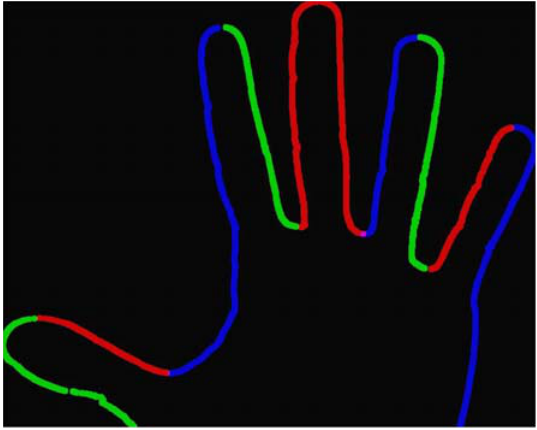
graph structure: starting the reading on the arrow, and then Figure 4. Example of a hand G j it follows counterclockwise (red, green,